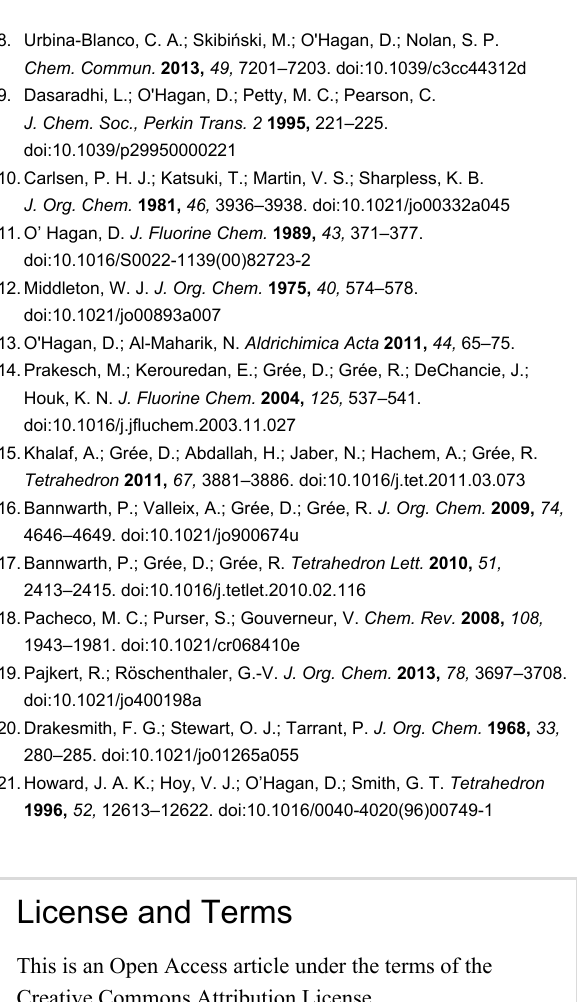
Figure 8: Conformational interconversion of 1,4-di-CF 2 motif.